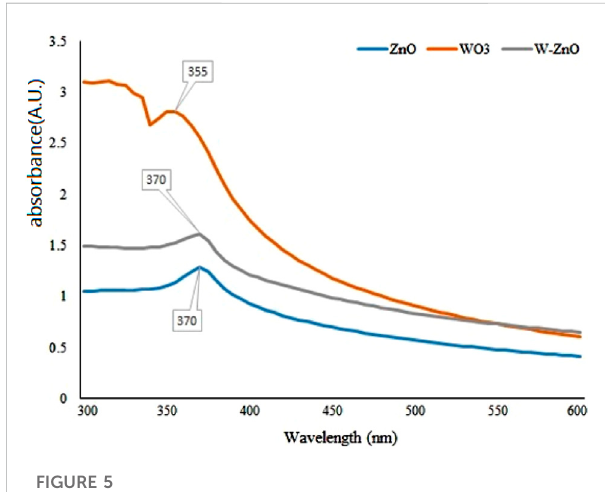
FIGURE 5 UV – Vis absorption spectra of ZnO, WO 3 and